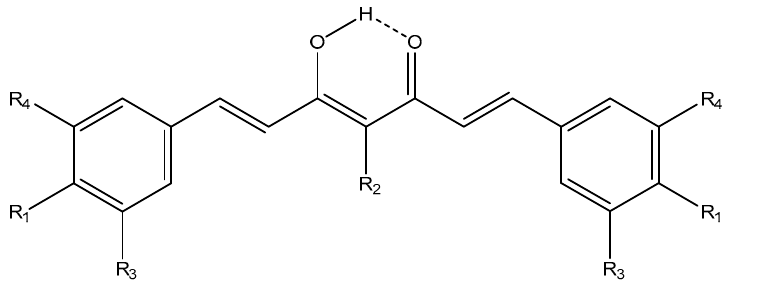
Figure 12. Analogues of curcumin and isocurcumin.